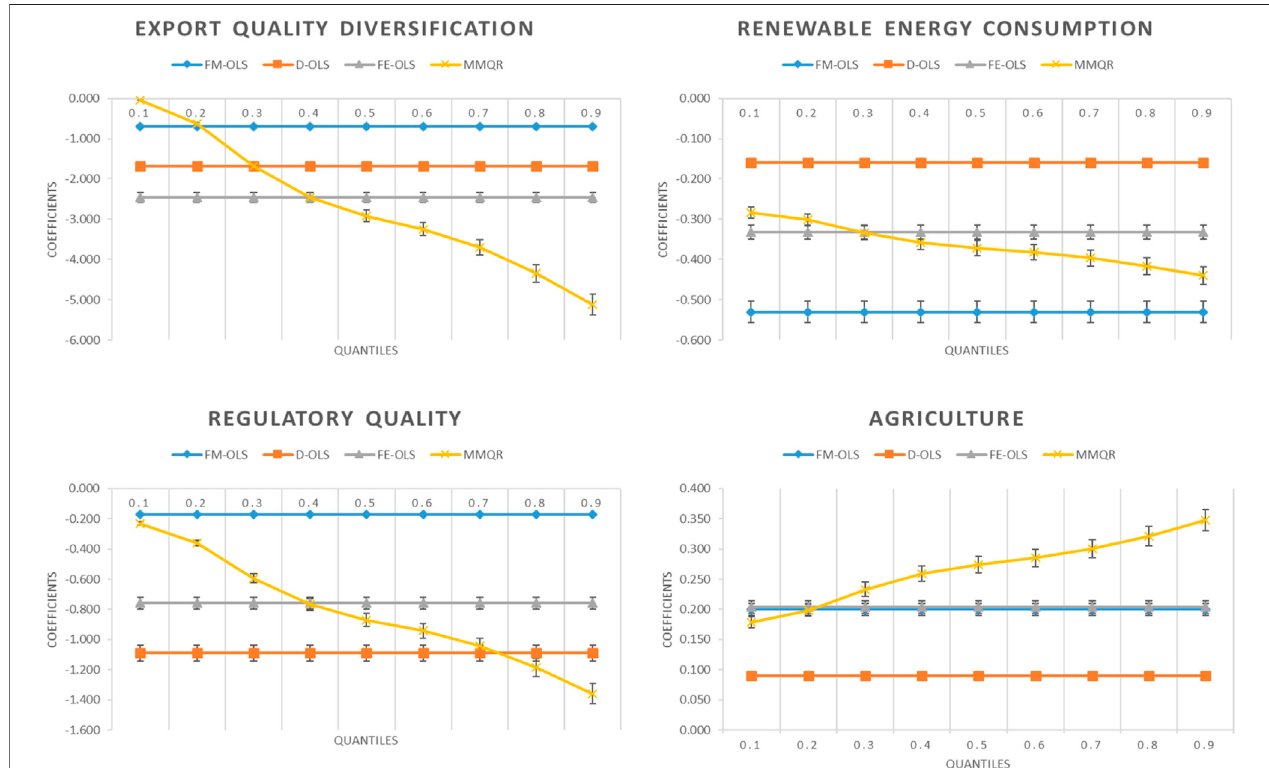
FIGURE 3 | Comparison of panel